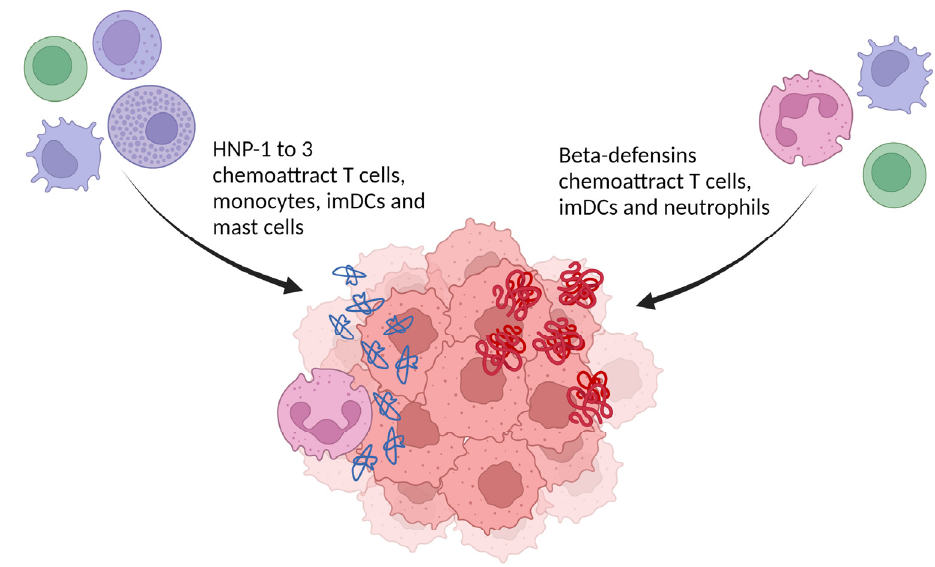
Figure 3. Chemoattractive effects of α - and β -defensins relevant in the tumor microenvironment. Those leukocytes can mediate an anti-tumoral immune response. (imDCs: immature dendritic cells). Created with